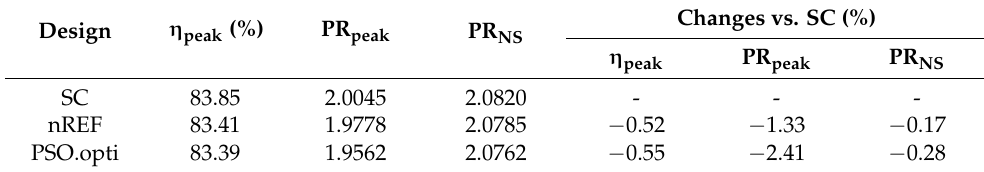
Table 6. Comparison of peak efficiency and pressure ratio between optimal design and other cases.